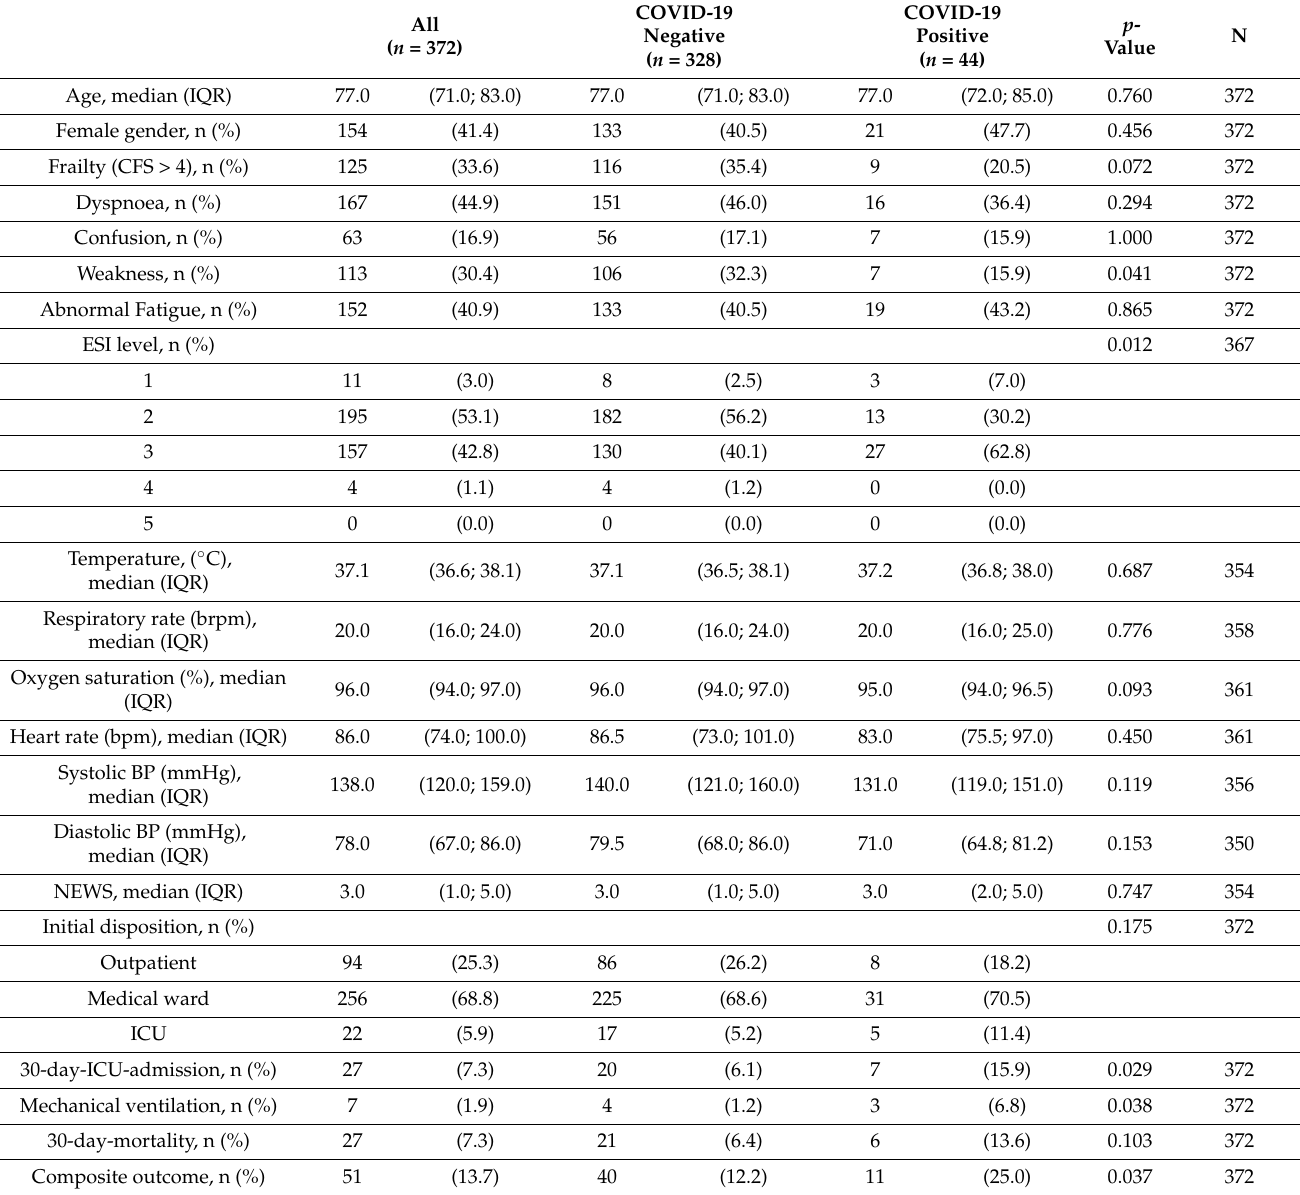
Table 1. Characteristics of ED patients aged 65 years and older at time of ED